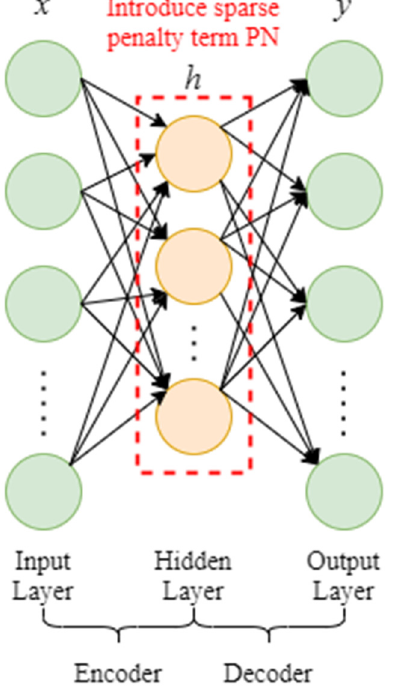
Figure 5. Layout of sparse AE.